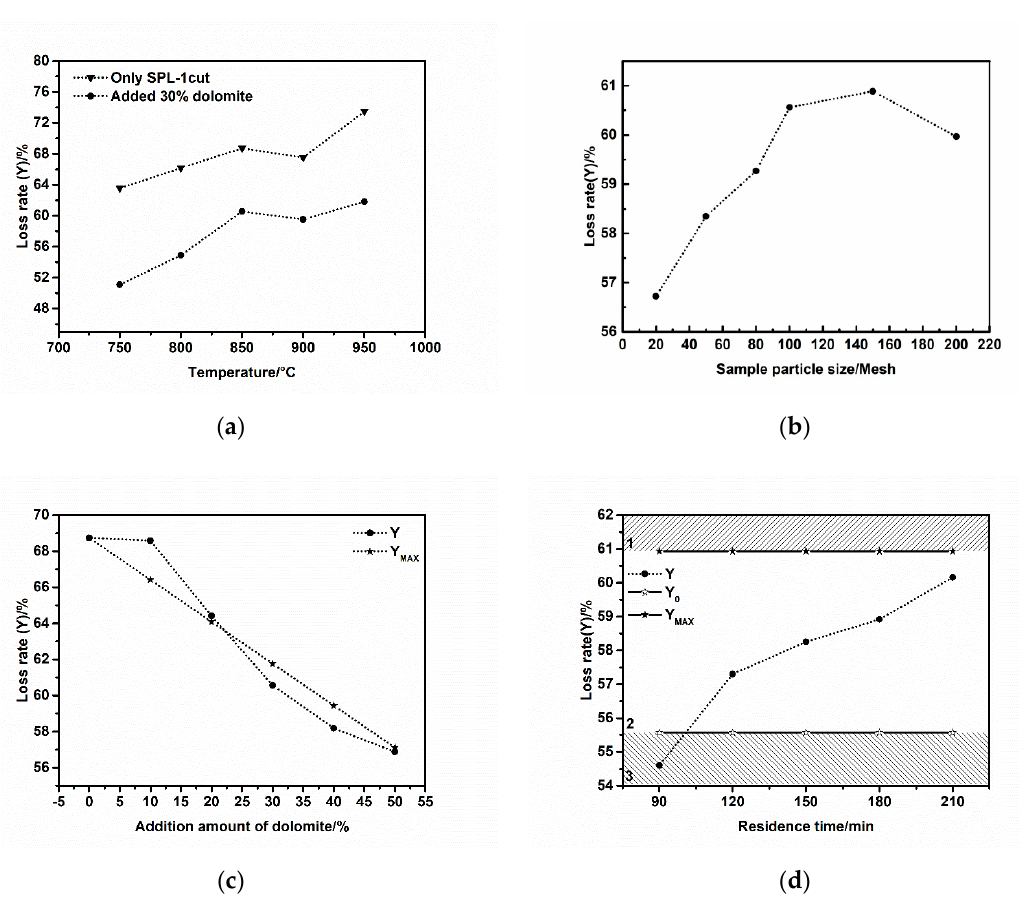
Figure 3. Trend of reaction loss ratio under di ff erent experimental conditions (( a ) 100 mesh, 30 wt% dolomite, 180 min; ( b ) 850 ◦ C, 30 wt% dolomite, 180 min; ( c ) 850 ◦ C, 100 mesh, 180 min; ( d ) 850 ◦ C, 40 wt% dolomite, 100